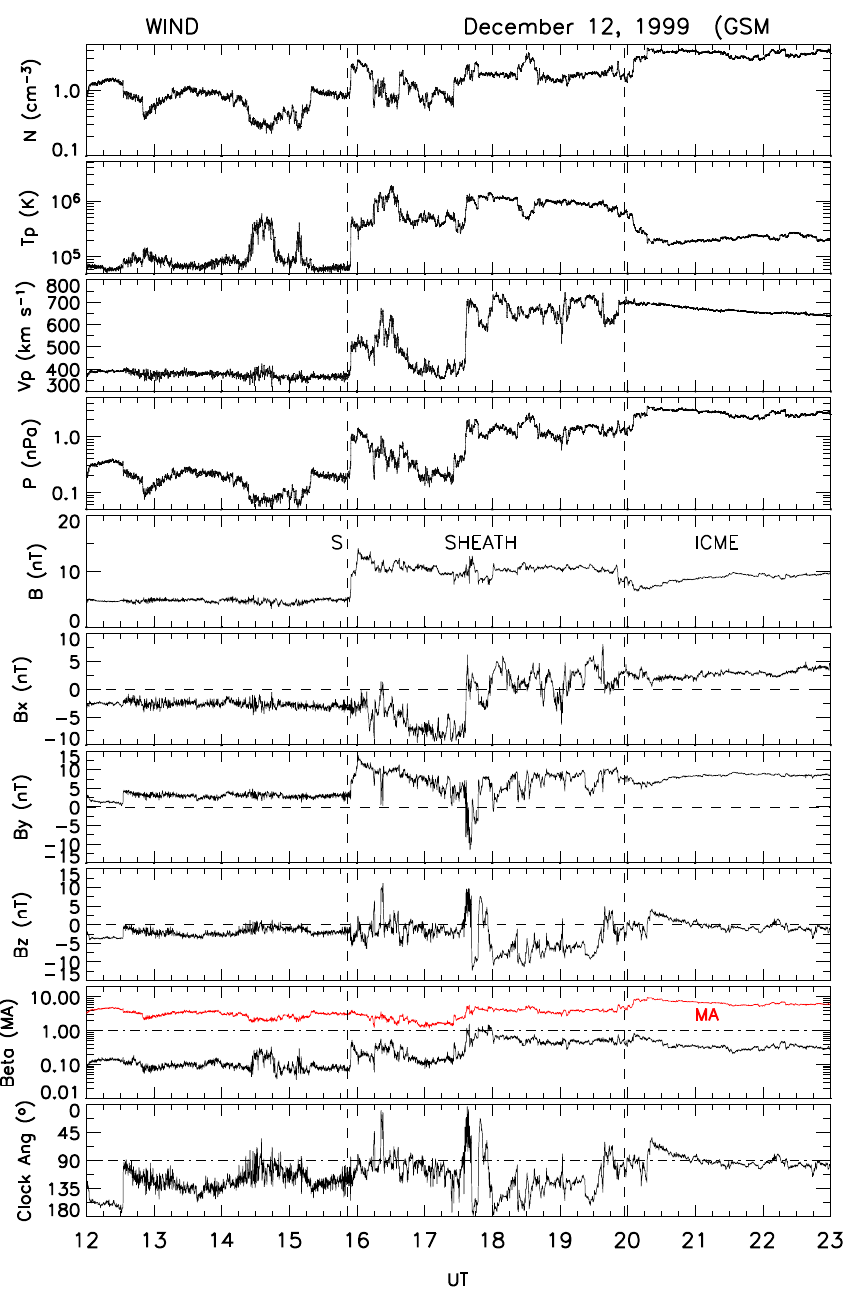
Fig. 15. Solar wind plasma and IMF data obtained from spacecraft Wind during the interval 12:00–23:00UT. The shock, sheath, and the leading part of an interplanetary CME (ICME) have been marked by vertical guidelines. The format is the same as that of Fig.